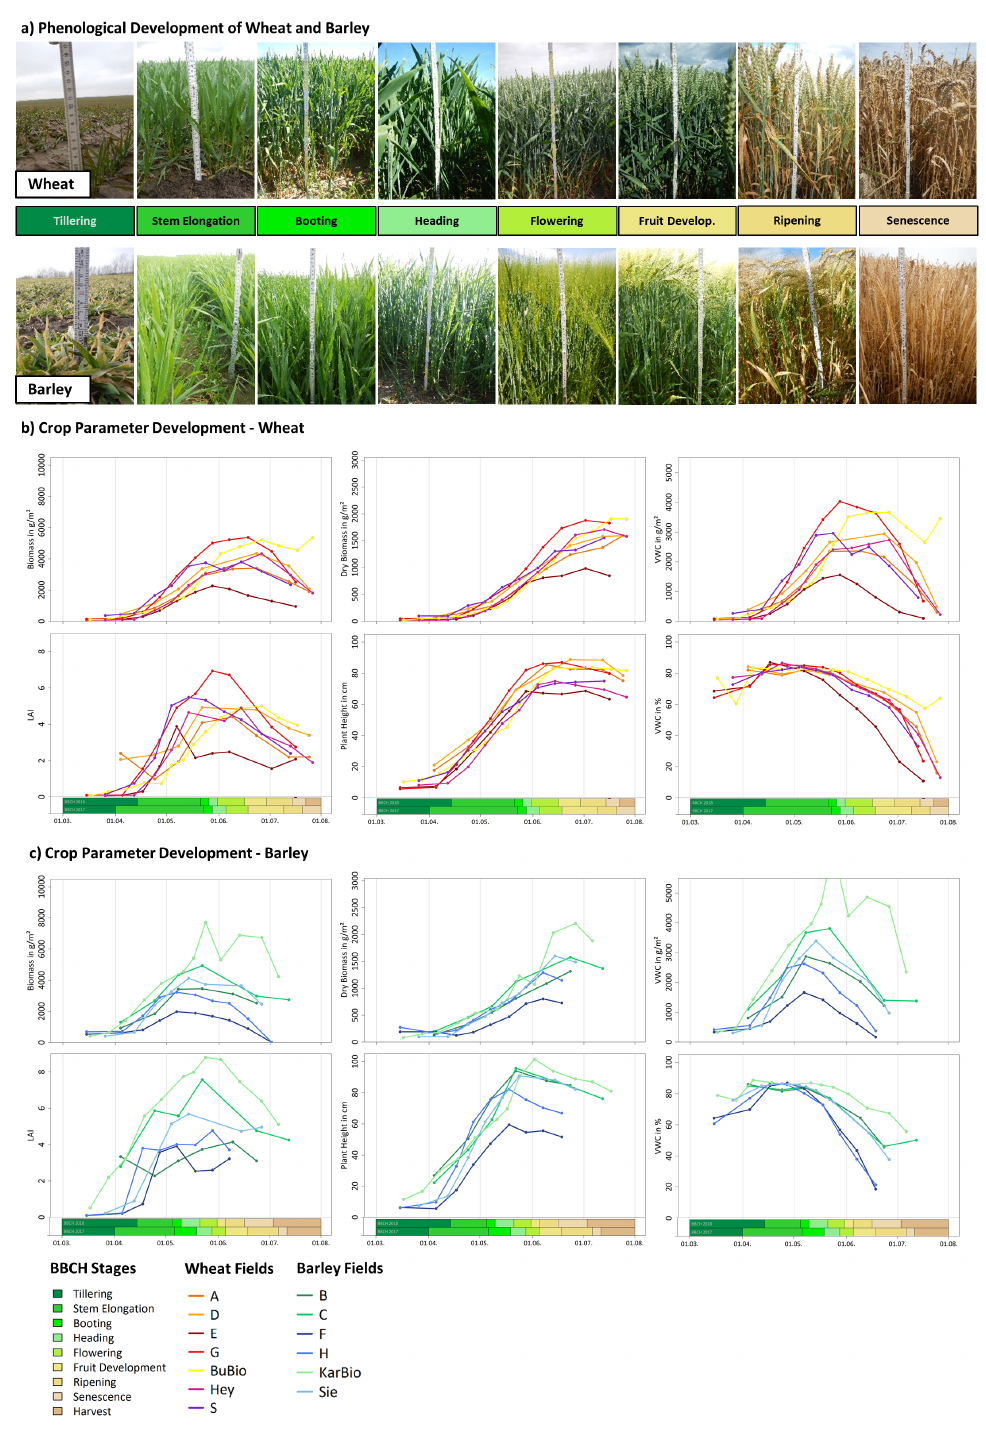
Figure 3. Characteristic appearance of wheat and barley in different BBCH stages ( a ) and development of crop parameters for all measured wheat fields ( b ) and barley fields ( c